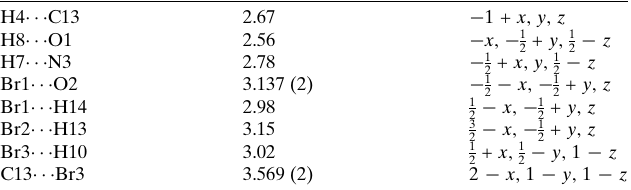
(Fig. 5). The red areas on the surface present short contacts and negative d values, which correspond to the C—H (cid:2) (cid:2) (cid:2) O norm hydrogen bonds mentioned above (Table 1). The red patch that appears around O1 is due to the C8—H8 (cid:2) (cid:2) (cid:2) O1 inter- action, which is critical for the molecular packing of the title compound. In form-1, the C—H (cid:2) (cid:2) (cid:2) Br interactions are also prominent (Akkurt et al. , 2022).